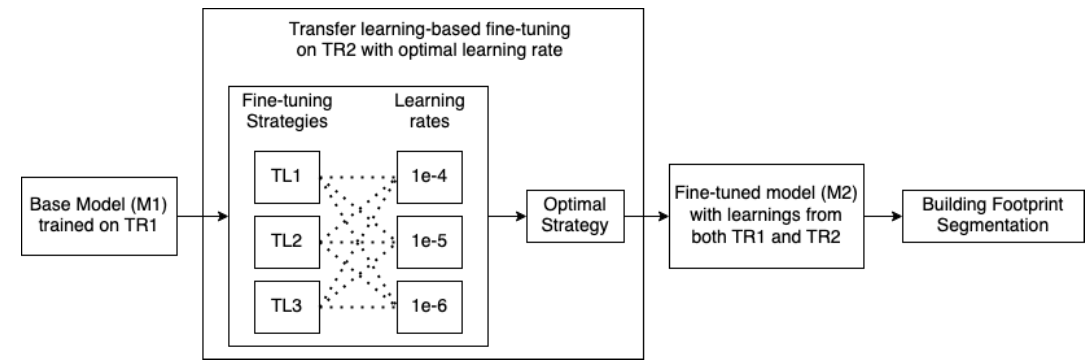
Figure 3 . Overall workflow of training and